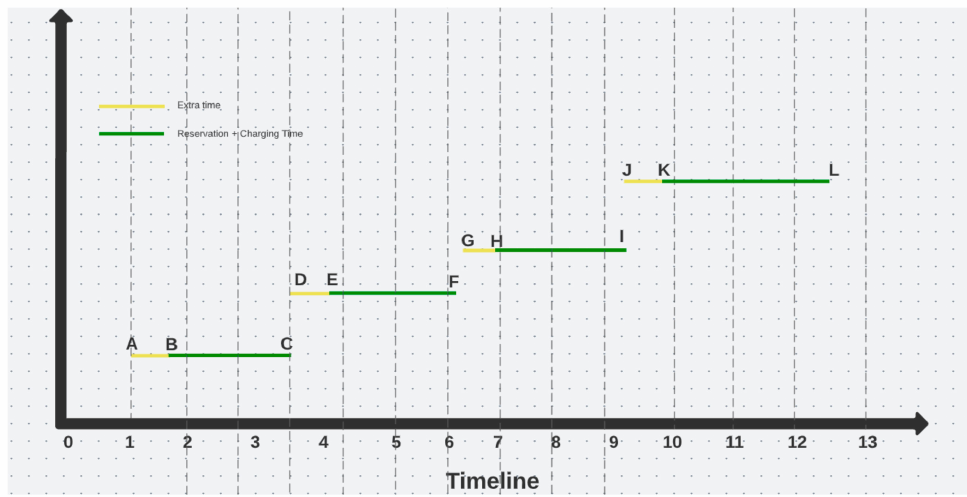
Figure 2. Custom Reservation Algorithm